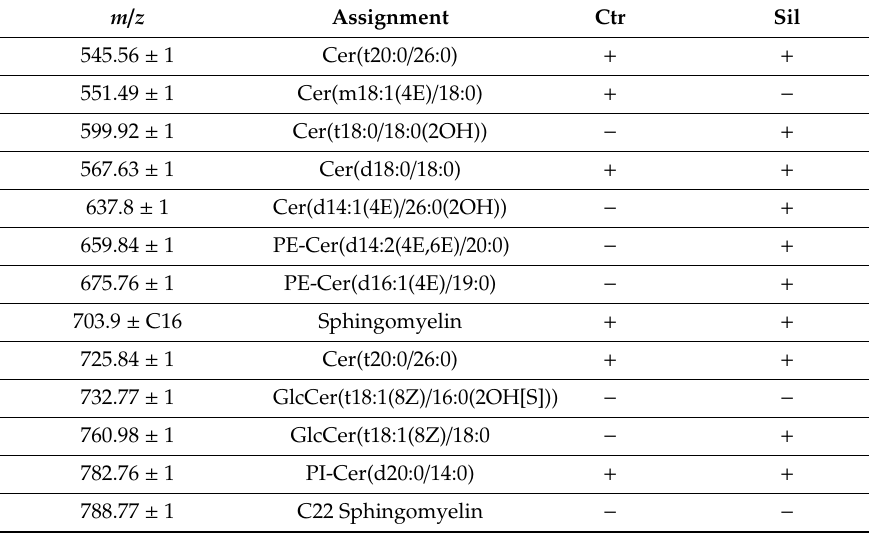
Table 1. MALDI-TOF mass spectra of cellular